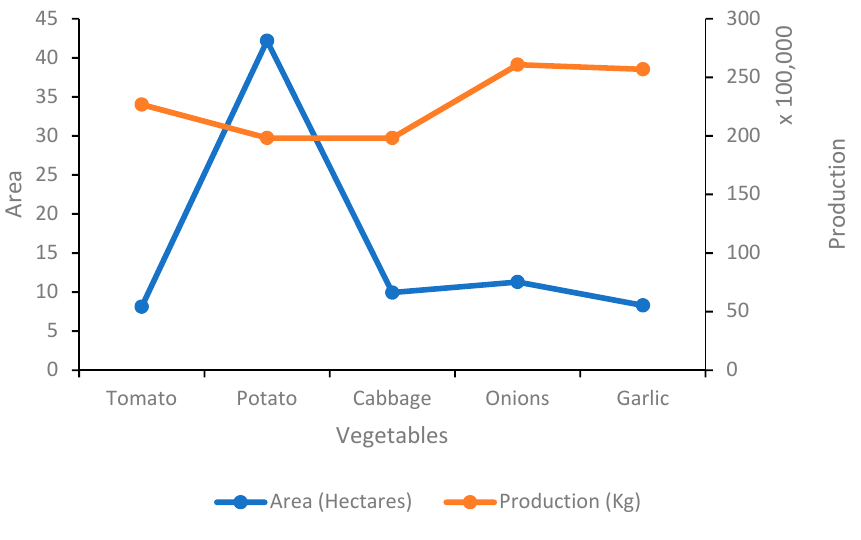
Figure 1. Production of vegetables by China in the year 2020.